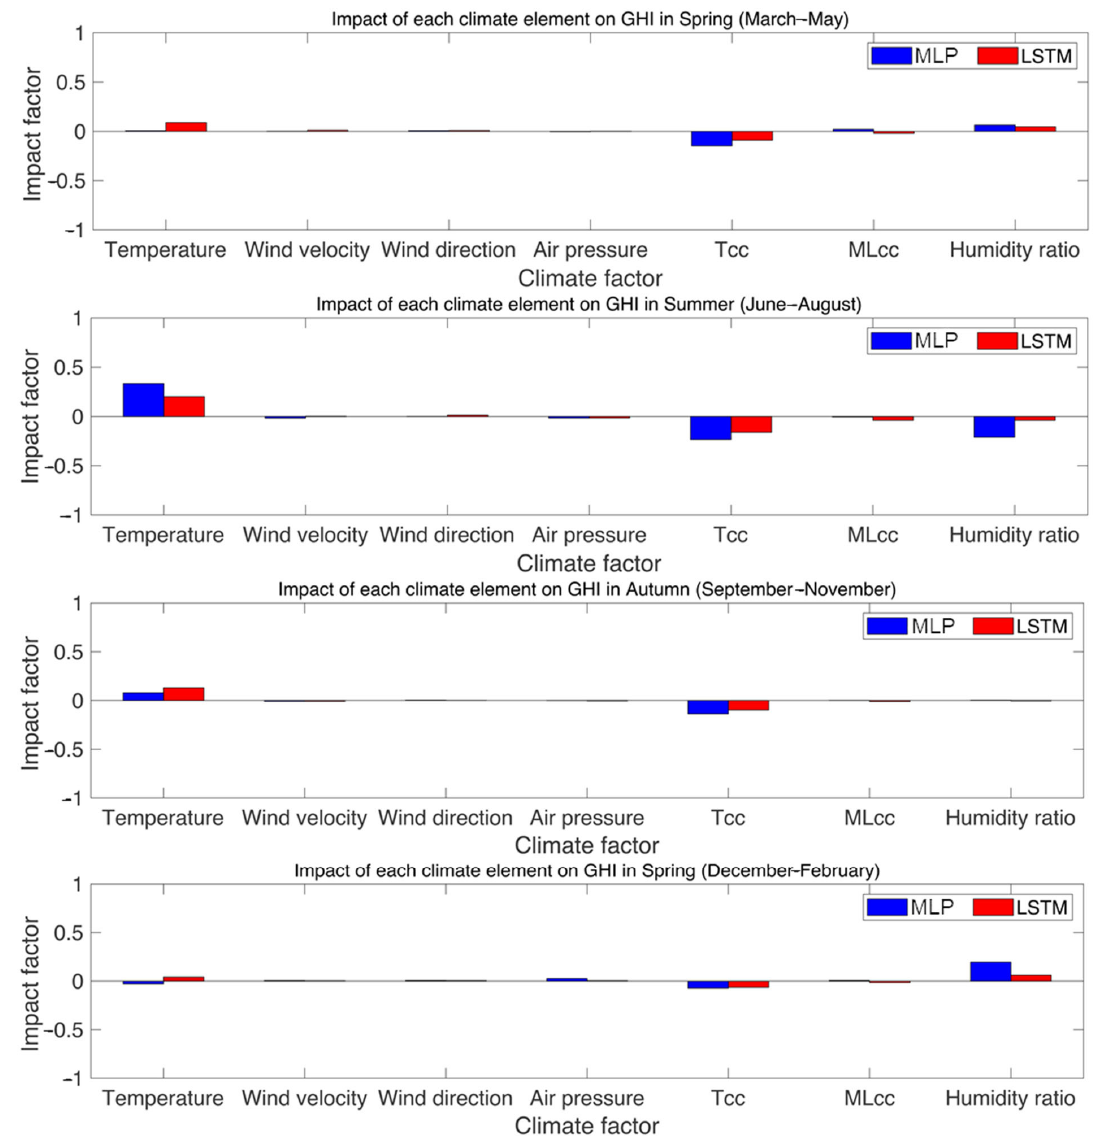
Figure 10. Impact factors of input climate elements determined by ANN models in four seasons.